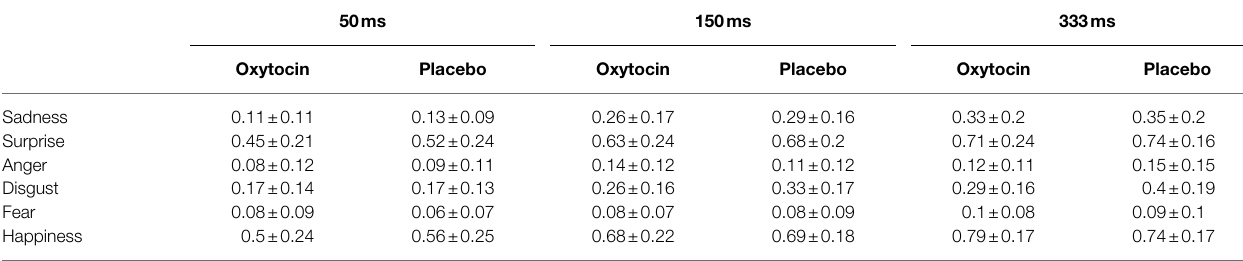
TABLE 3 | The recognition accuracy of standardized micro-expression recognition task in Study 2 ( M ± SD ). 50 ms 150 ms 333 ms Oxytocin Placebo Oxytocin Placebo Oxytocin Placebo Sadness